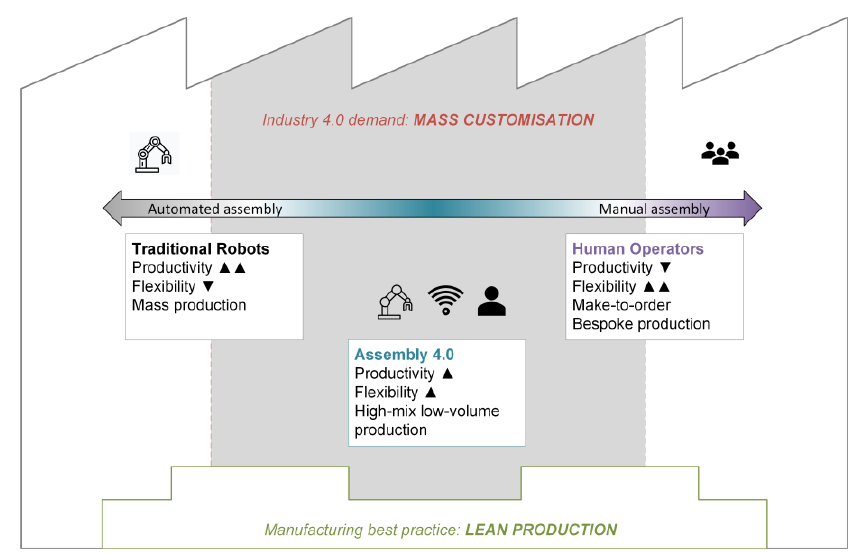
Figure 1. Key concepts used for the systematic literature review.